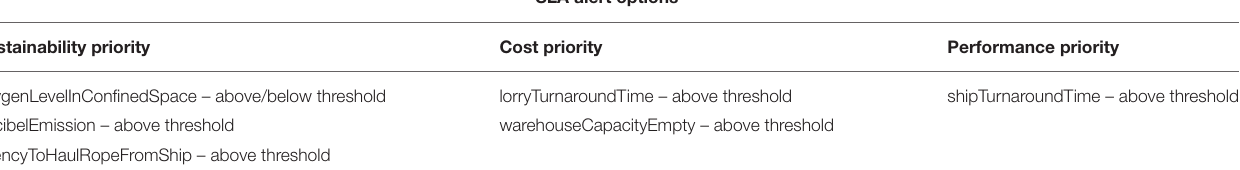
TABLE 2 | SLA alert options.